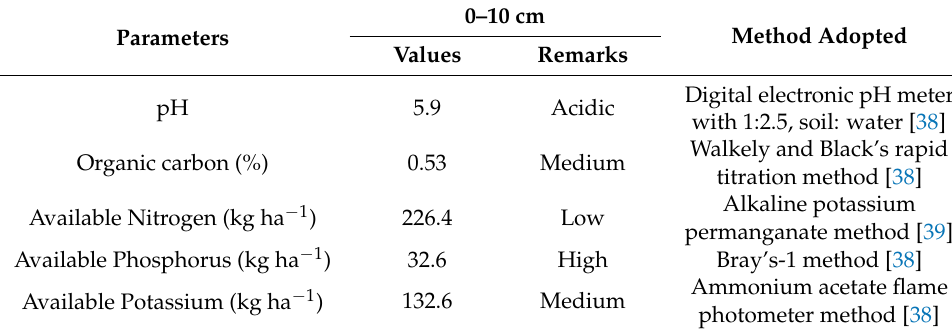
Table 2. Chemical composition of the soil.